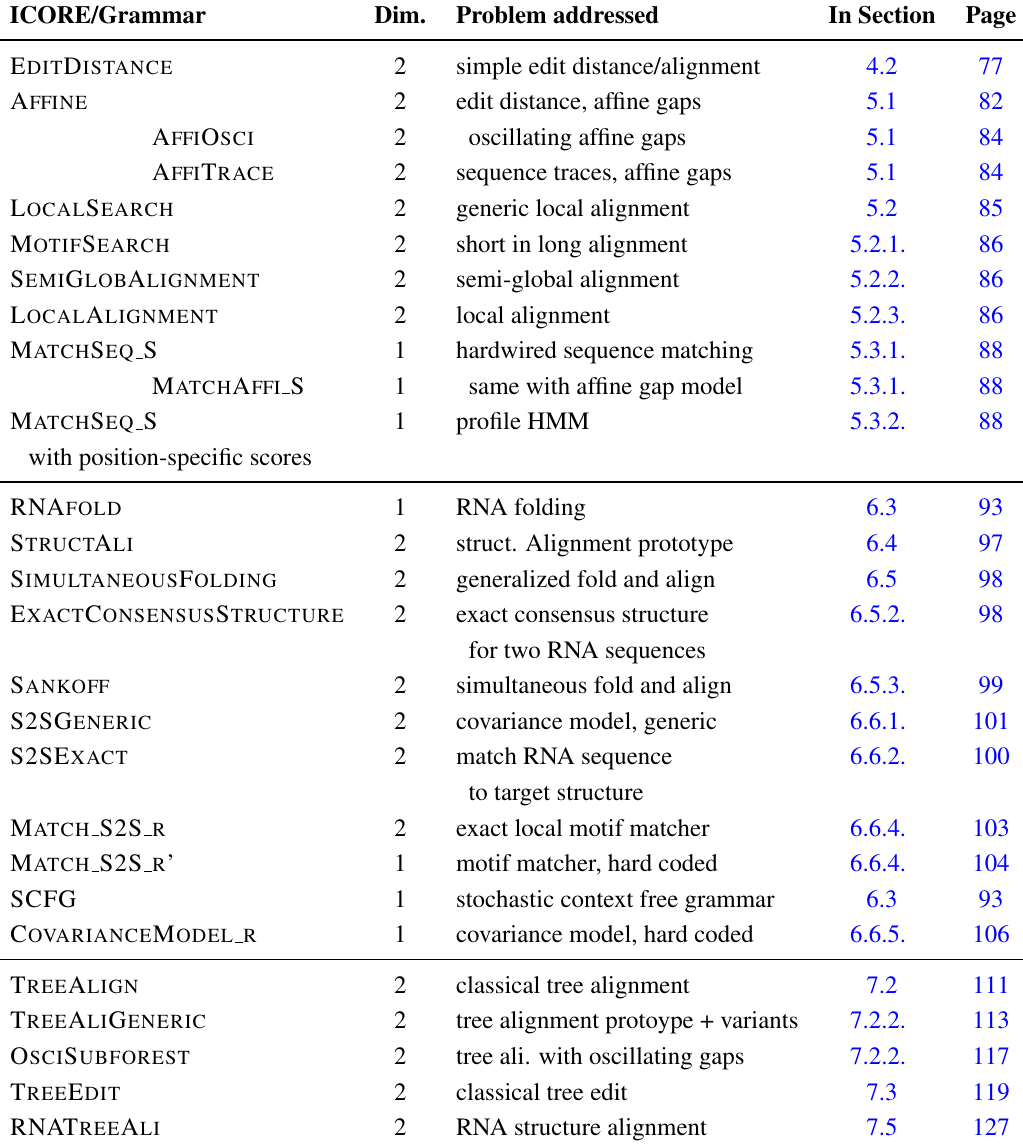
Table 1. A summary of the Inverse Coupled Rewrite Systems (ICOREs) presented in this manuscript. In a few cases, not a complete ICORE is specified, but only a grammar that extends another